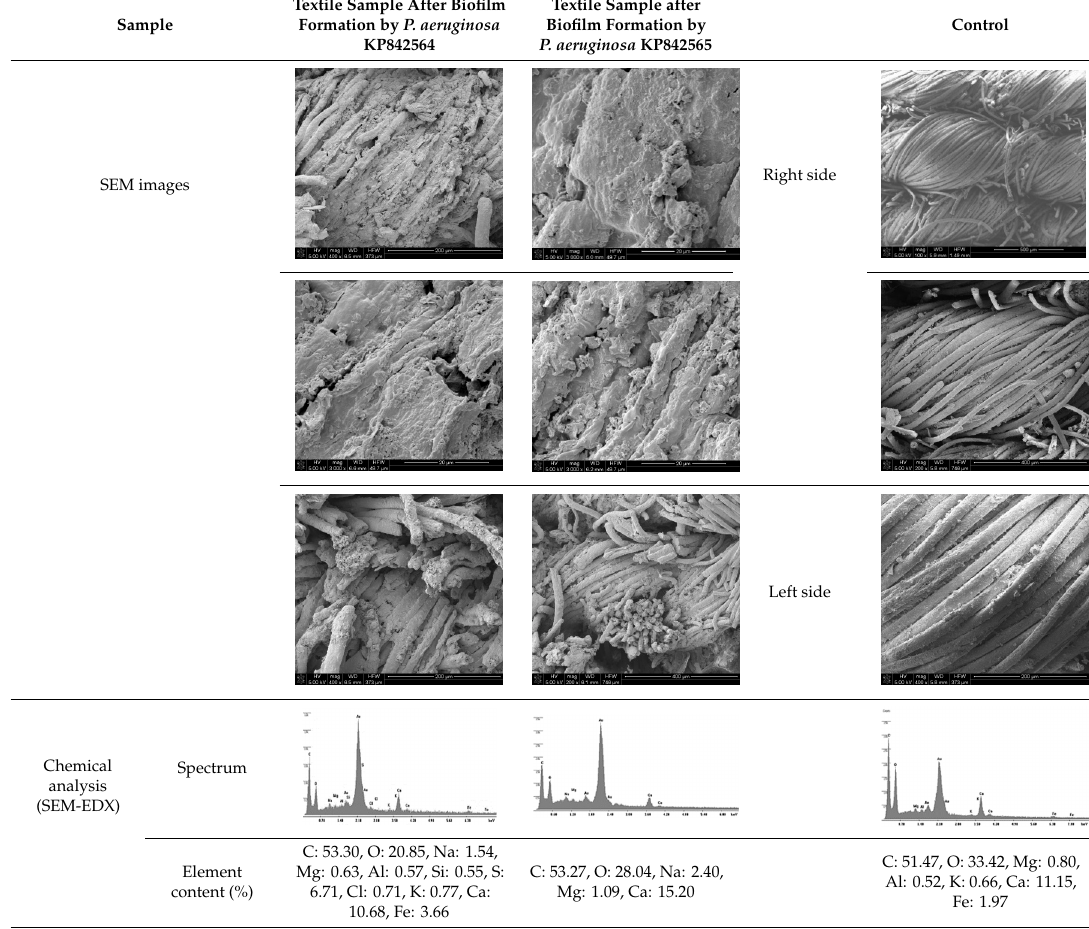
Table 3. Microscopic and chemical analysis of archeological textile samples after biofilm formation by P. aeruginosa isolates. Textile Sample After Sample Sample Biofilm Formation by Sample Sample